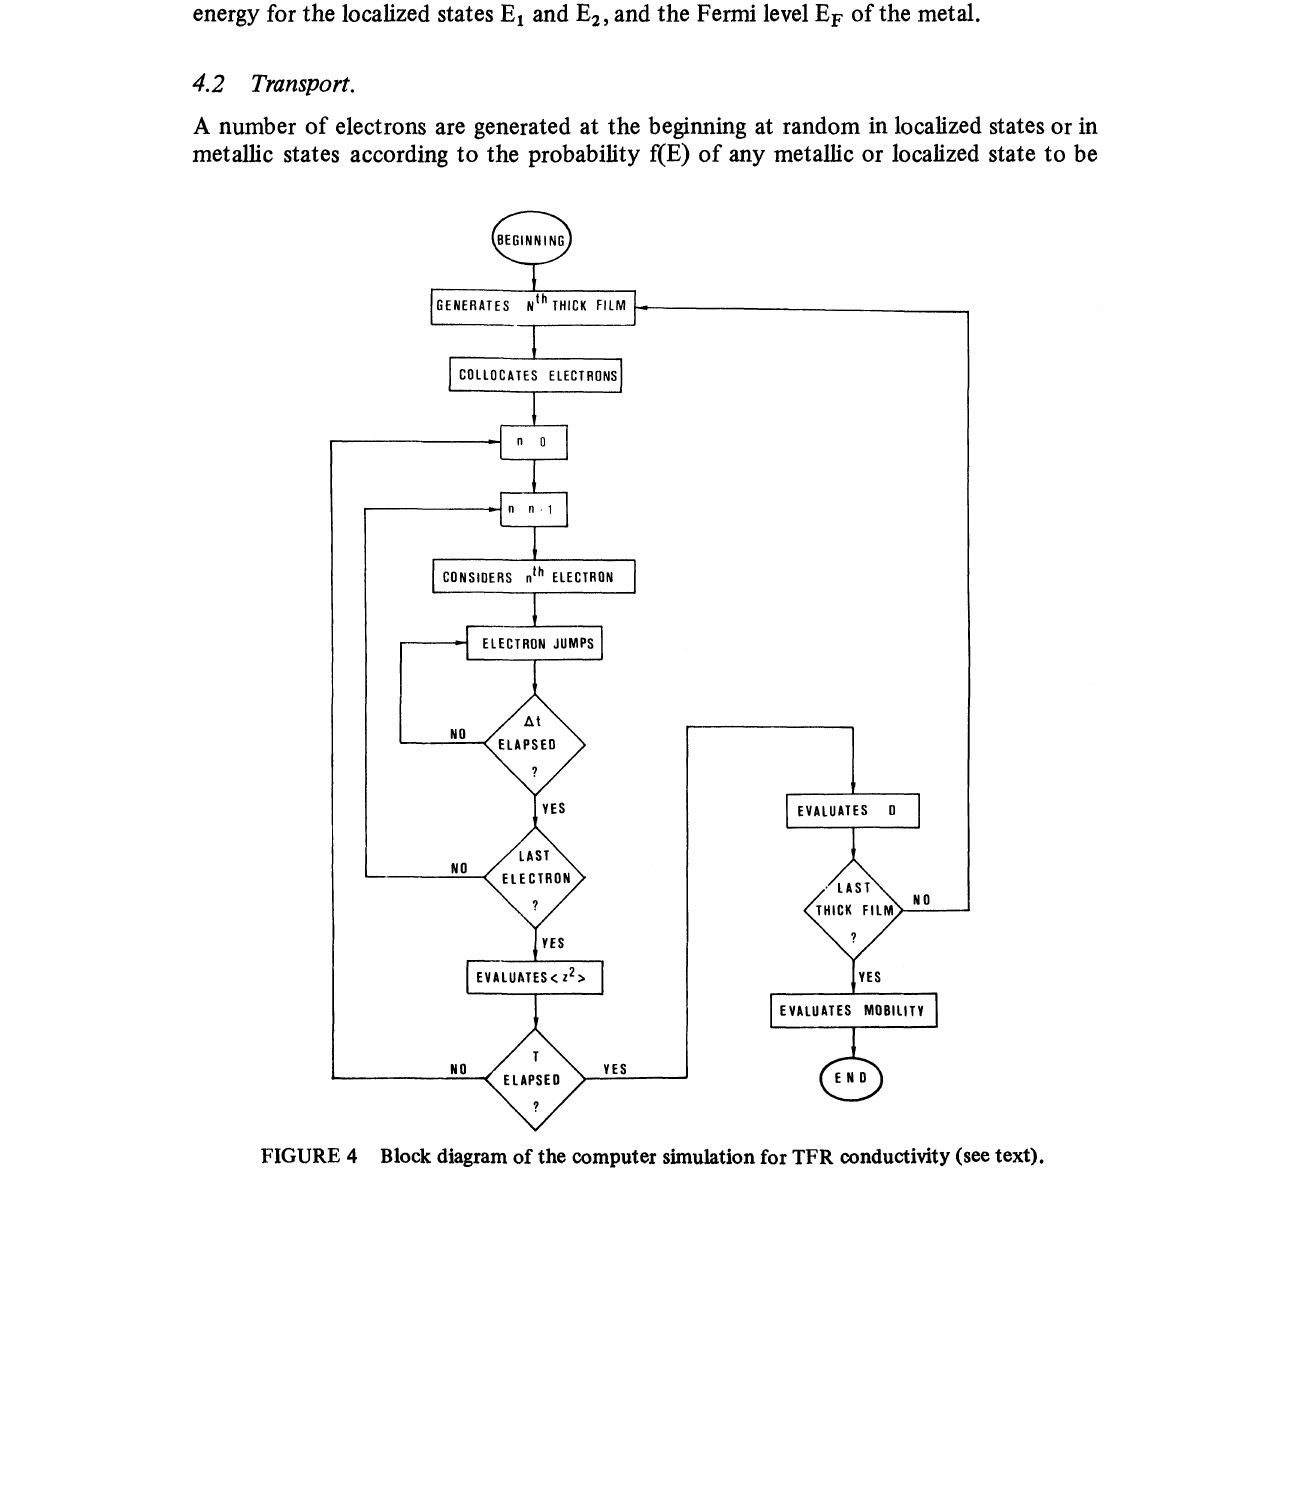
FIGURE 4 Block diagram of the computer simulation for TFR conductivity (see